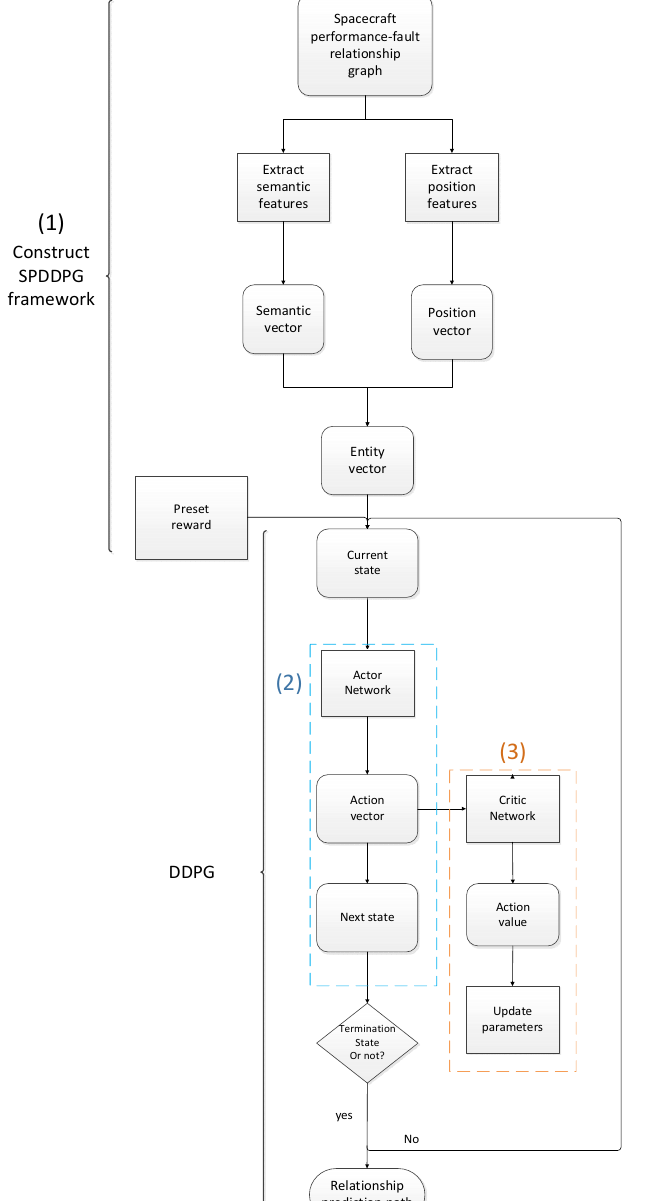
Figure 1. The reasoning process of SPDDPG.